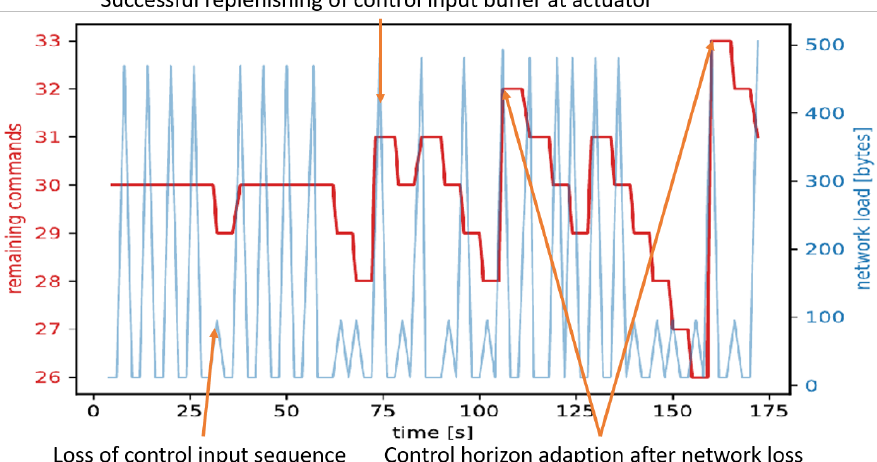
Figure 15. Command buffer state on actuator side under the influence of packet losses. The adaption of the control horizon length as reaction to the measured losses prevents the remaining control input buffer size to fall below N min + N th =